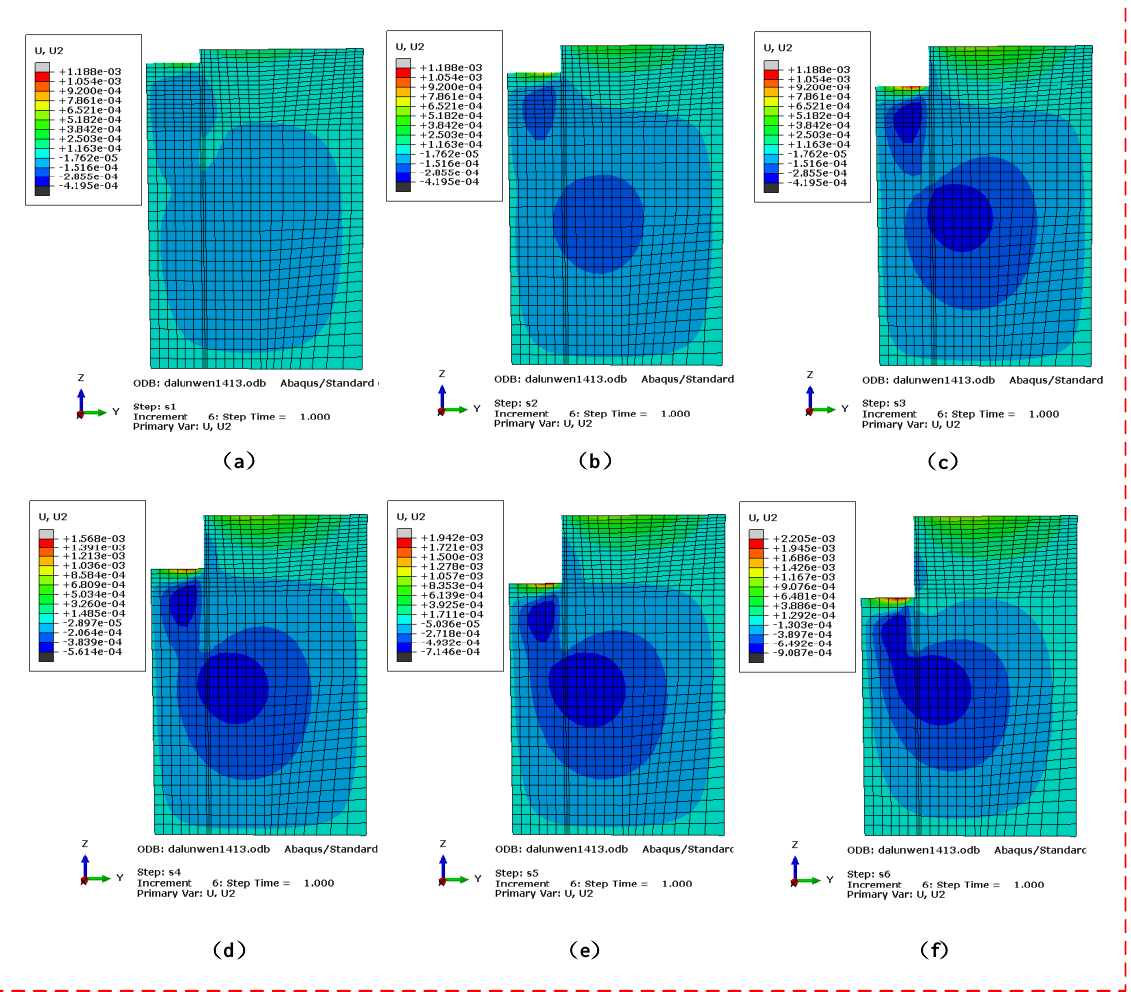
Figure 11. Cloud map of soil’s horizontal displacement: ( a ) underground first floor; ( b ) underground second floor; ( c ) underground third floor; ( d ) underground fourth floor; ( e ) underground fifth floor; ( f ) underground sixth floor.